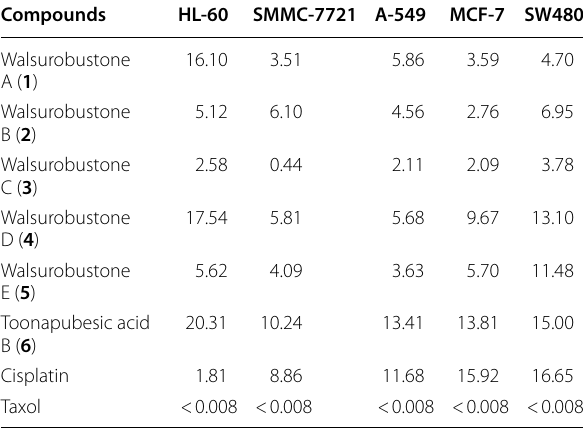
Table 3 Cytotoxicity Data for Compounds 1 – 6 against the cancer cell lines